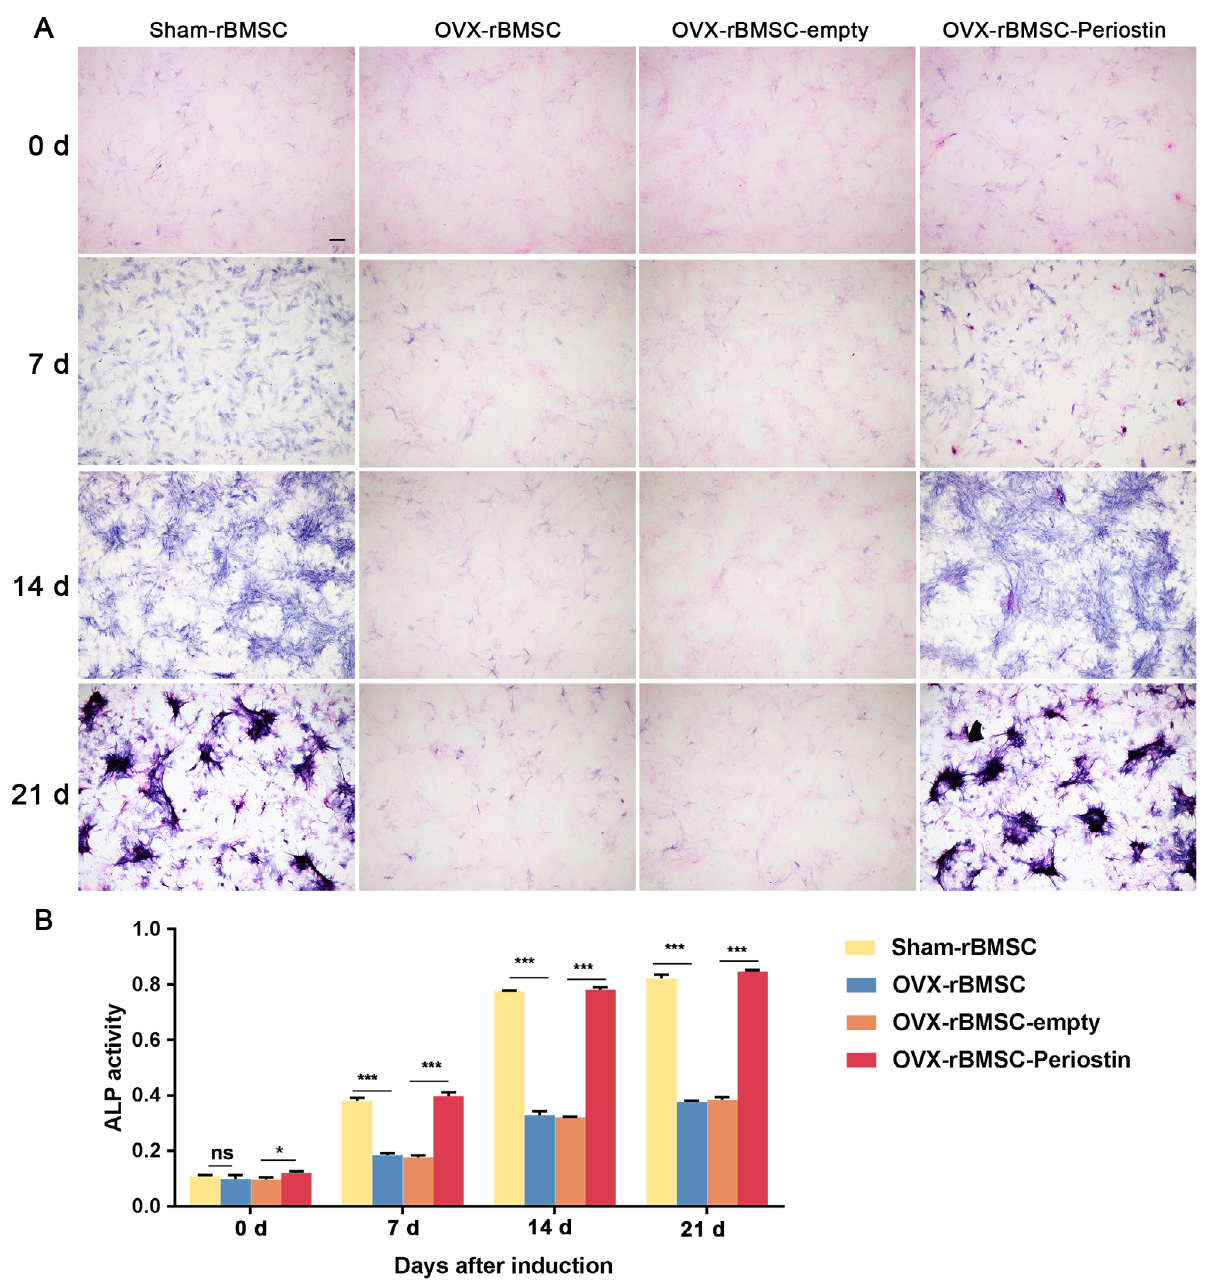
Figure 5 ‒ Overexpression of periostin promotes ALP production by OVX-BMSCs. (A) Representative images of ALP staining of the indicated groups on day 0, day 7, day 14 and day 21 after osteogenesis induction. The images are from 1 of 3 independent experiments; Magnification × 40, scale bar = 200 μm. (B) Graph shows quantitative analyses of ALP activity of the indicated groups on day 0, day 7, day 14 and day 21 after osteogenesis induction. Data are presented as the mean ± SD of 3 independent experiments. ns, not significant. * P < 0.05, *** P < 0.001; One-way